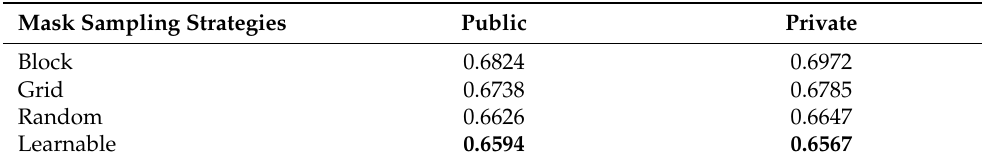
Table 3. Comparisons with previous results for mask sampling strategies based on the ViT backbone of GeoLifeCLEF 2022.